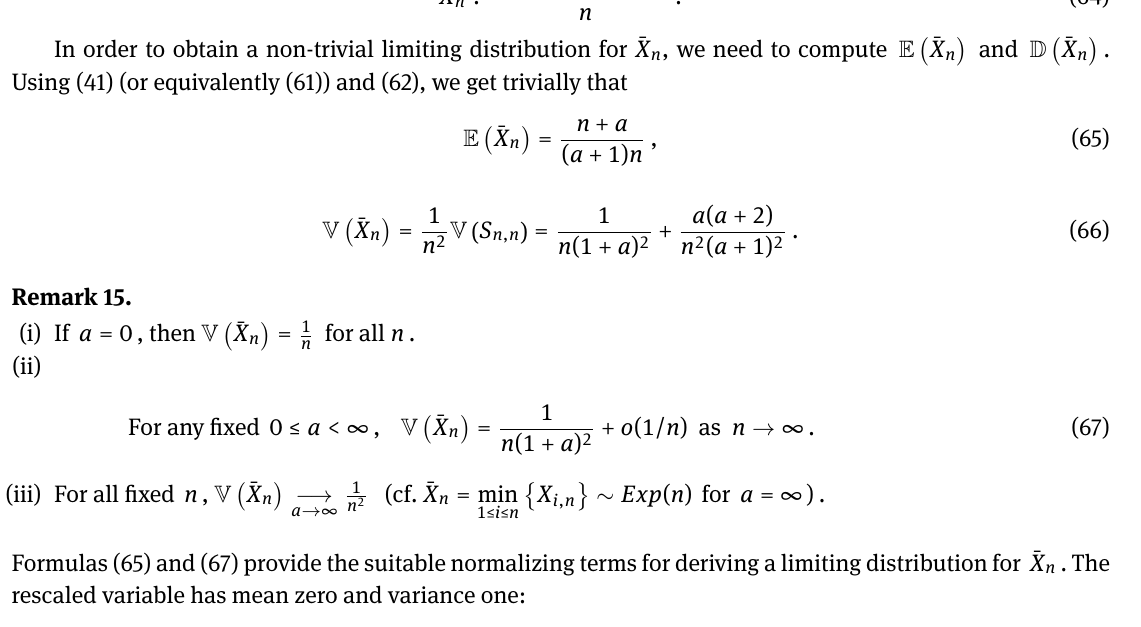
Figure 9: Probability density functions of the sum of the components and their gamma approximations for n = 30, 50, 100 . The L 1 -distances are (cid:107) g − ˜ g 30 (cid:107) (cid:117) 0.0254 , (cid:107) g S 30 + O (1/ n ) , so the same asymptotics holds for the mode of S n + a −1 a +1